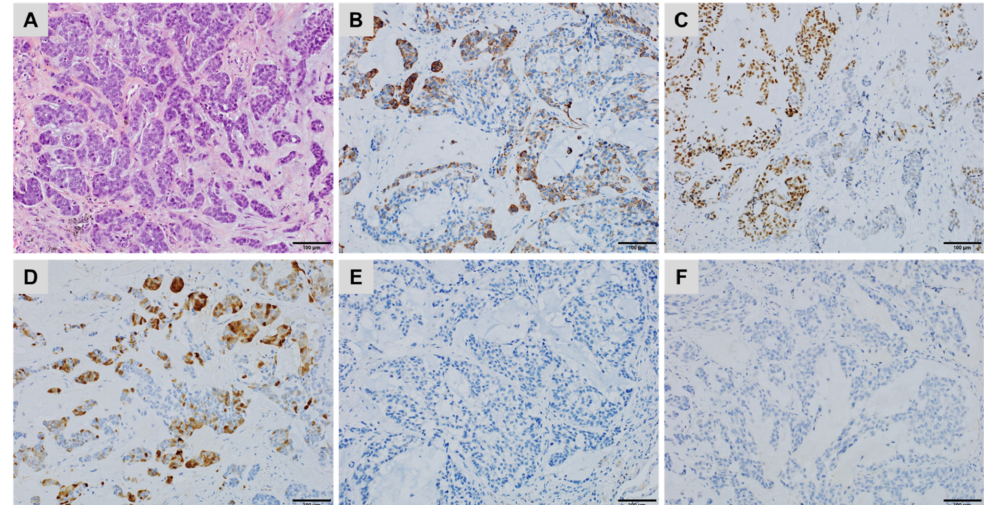
Figure 5. A metastatic urachal adenocarcinoma in the left lung (( A ) haematoxylin, eosin and safran) showing patchy staining for ( B ) CK34 β E12, ( C ) CDX2 and ( D ) Calretinin but no staining for ( E ) p40 and ( F ) GATA3 (( B – F )